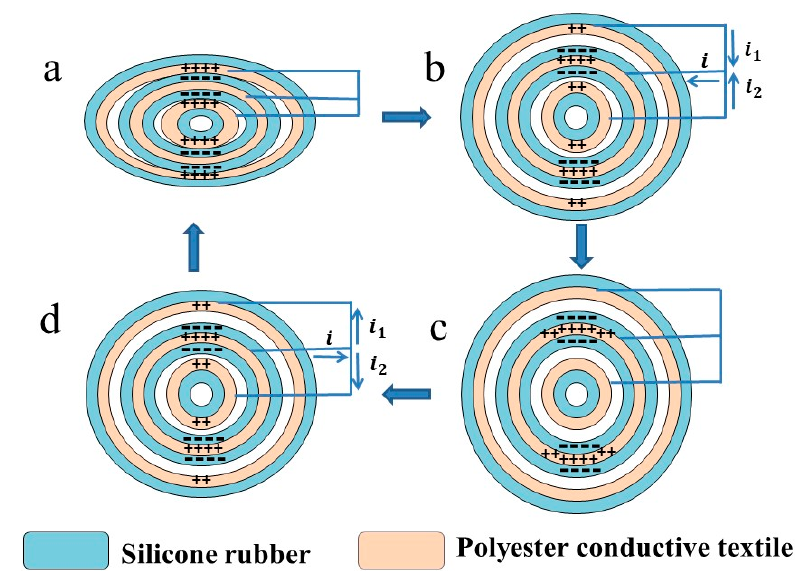
Figure 2. Schematic illustration of the power generation mechanism of the SNTN. Triboelectric charge distribution of one current generation cycle: ( a ) full-contact state; ( b ) releasing state; ( c ) full-separation state (initial state); ( d ) pressing state.